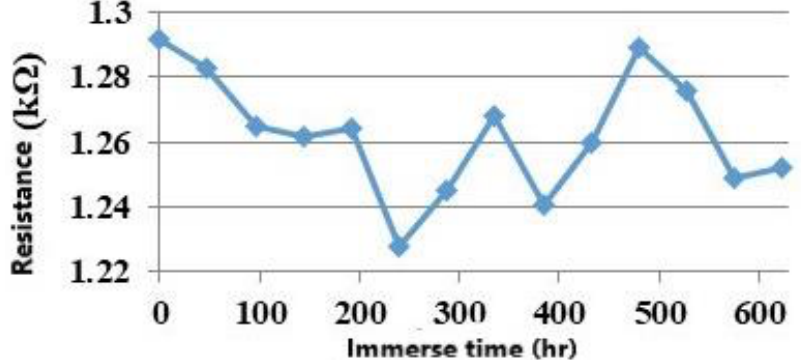
Figure 18. Resistance and the immerse time inside the electrolyte.